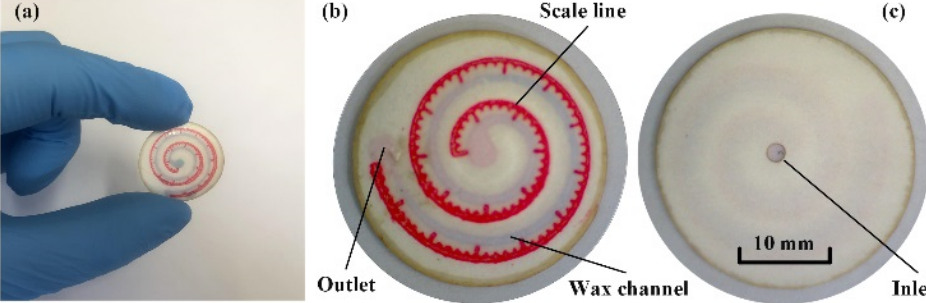
Figure 3. ( a ) Photograph of a P-SRMC chip, ( b ) top view, and ( c ) bottom view of the assembled chip.